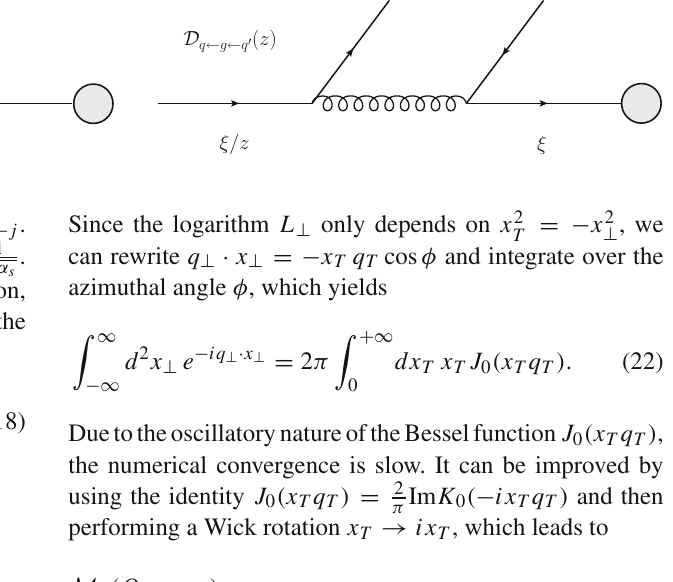
Fig. 3 Sample one- and two-loop ingredients to the beam functions. The incoming parton is on the left and the grey blob indicates the hard